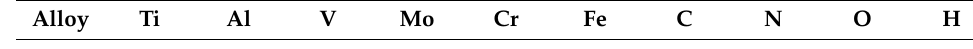
Table 1. Chemical composition (wt %) of the spherical powders.